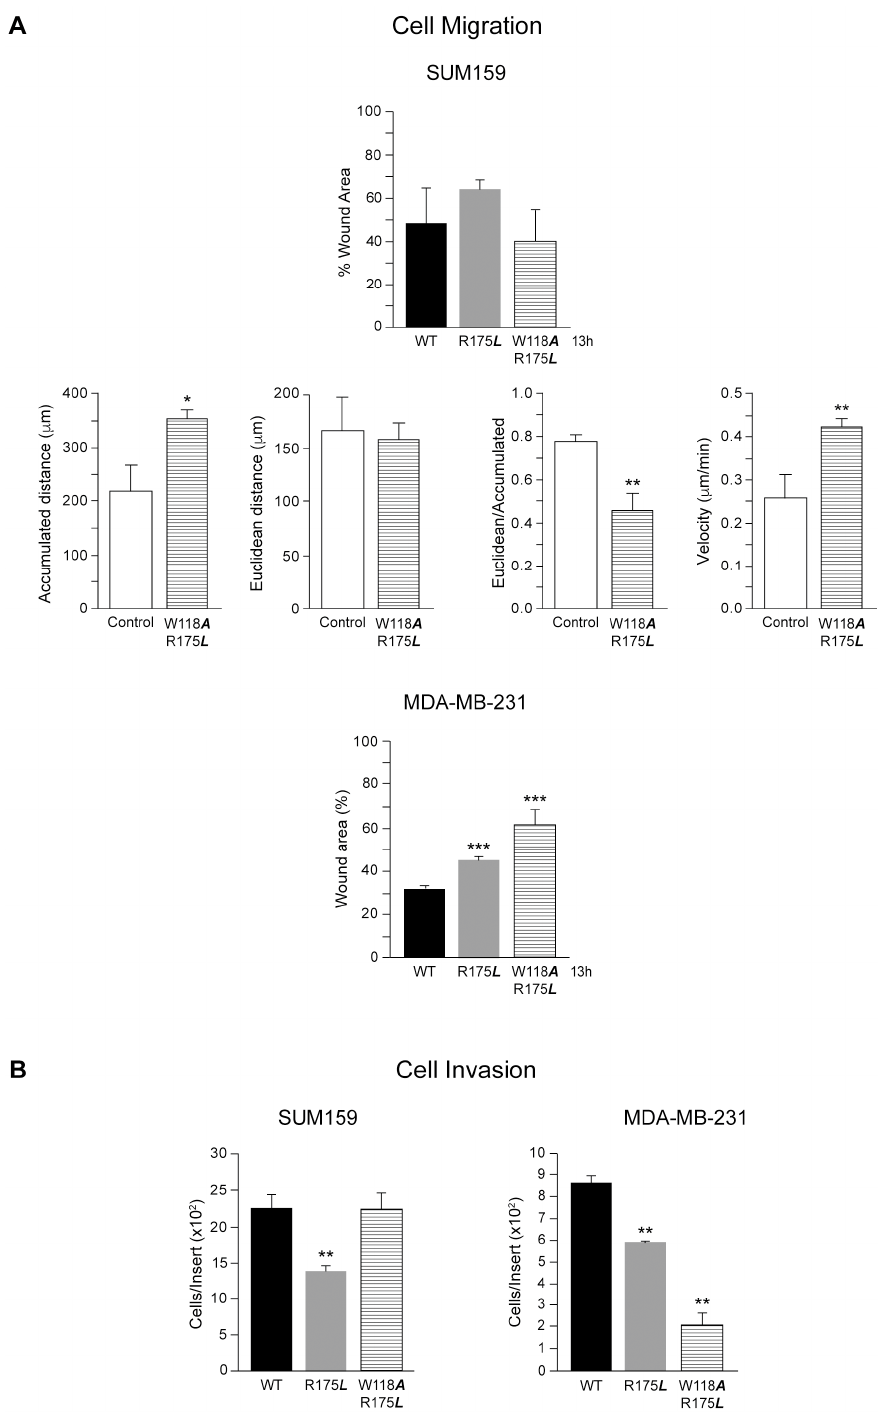
Figure 4. Effect of c-Src variants expression in SUM159 and MDA-MB-231cellular migration and invasion. Migration of cells was analyzed by wound-healing assays, and tracking analyses ( n = 3), as described in Materials and Methods in SUM159 and MDA-MB-231 cells ( A ). Additionally, tracking analyses of W118A/R175L to determine the cell migration of at least 100 individual cells determine the Accumulated distance, Euclidean, and the Velocity of migration to evaluate the ration of Euclidean/Accumulated distance that define random migration. ( B ) The capability of cells to migrate through a layer of Matrigel was employed to determine cell invasion (see Materials and Methods) in both SUM159 and MDA-MB-231 conditionally expressing c-Src variants. The control value is similar to that in Figure 2. Results of three independent experiments ( n = 3) were expressed as the mean ± SD. The statistical significance is referred to cells expressing c-Src-wt, * p < 0.5, ** p < 0.01, *** p < 0.001.